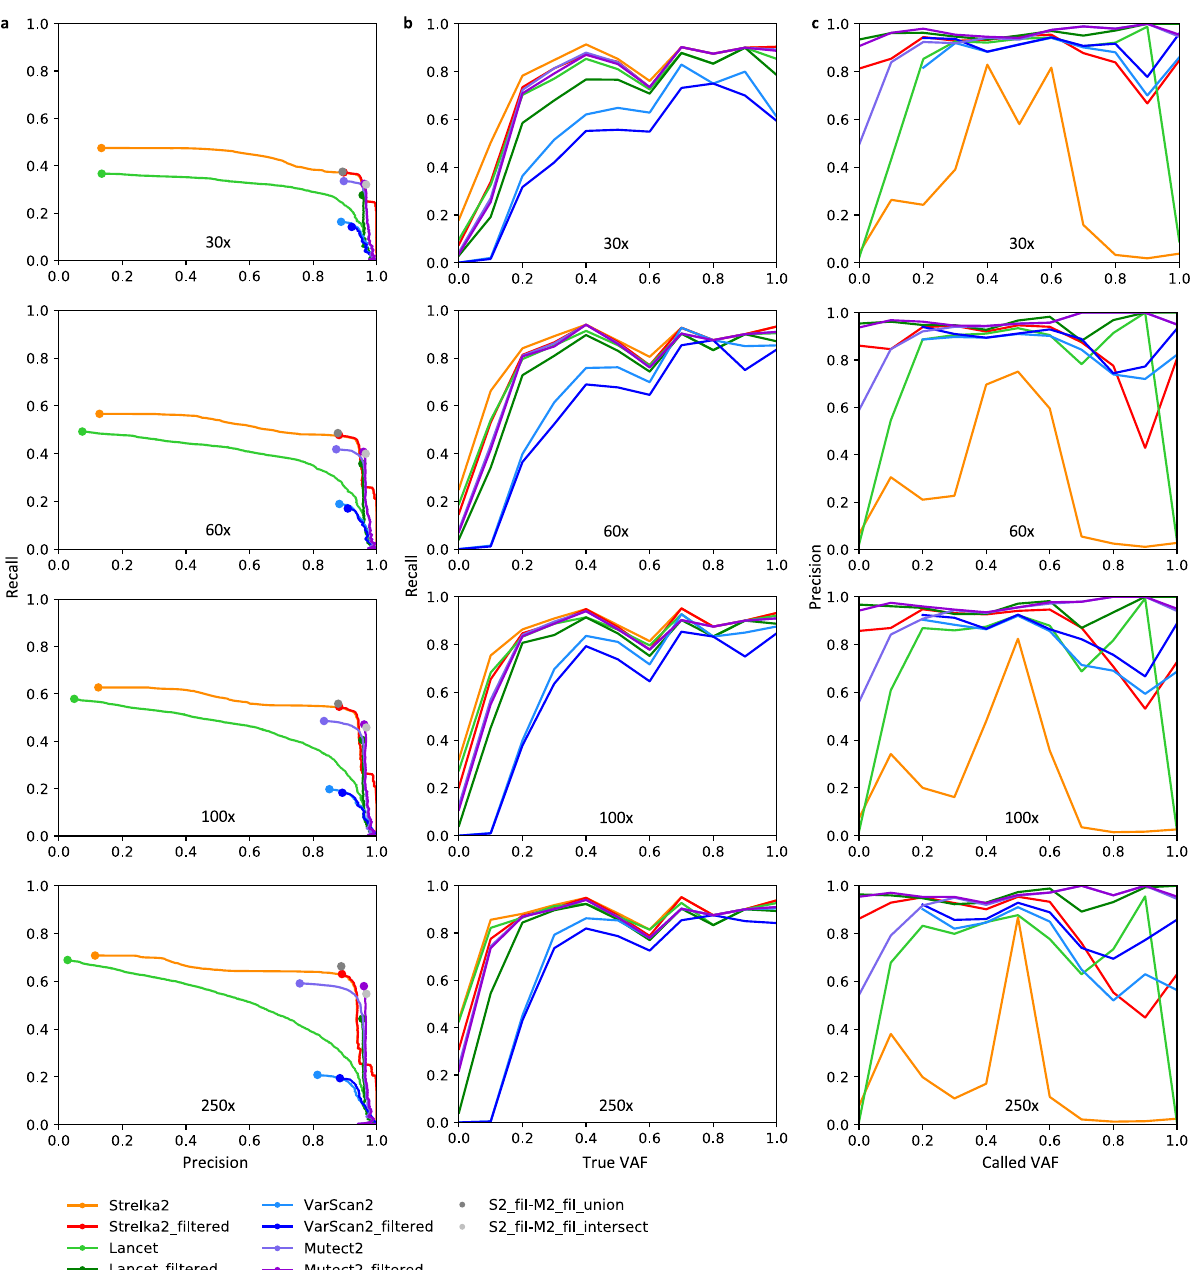
Fig. 3 Performance of variant callers applied to sequencing data from tumour S3R3 with 100% purity at 30x, 60x, 100x and 250x coverage. Each variant calling method was assessed across target exon regions, both pre- and post- fi ltering (denoted with _ fi ltered suf fi x). S2_ fi l-M2_ fi l_union is the call set resulting from the union of results from Strelka2_ fi ltered and Mutect2_ fi ltered, with the intersect of results from those callers denoted by S2_ fi l- M2_ fi l_intersect. a Precisions – recall curves. b Recall according to true variant allele frequency (VAF). c Precision according to called variant allele frequency. Source data are provided as a Source data fi